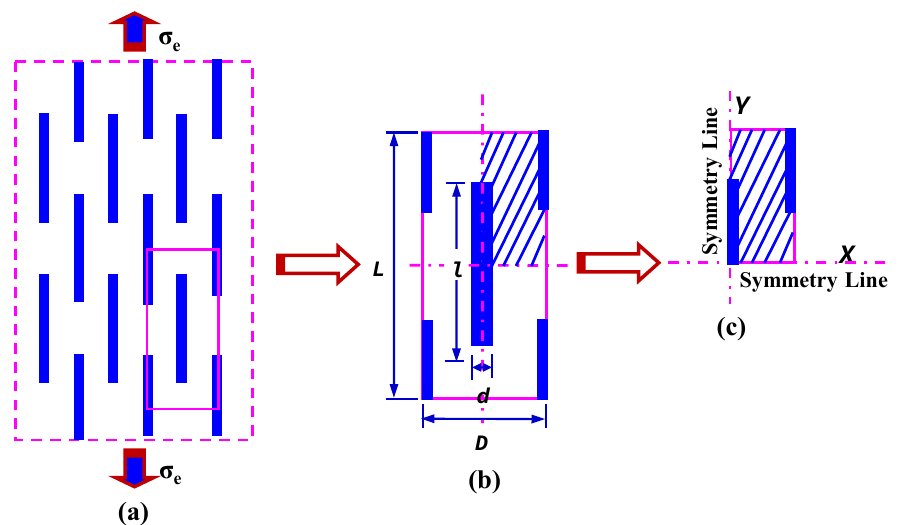
Figure 3. Representative volume element (RVE) of the stagger model used for the present computational scaling analysis. ( a ) Idealized identical staggering clay platelets; ( b ) a typical RVE; and ( c ) a quarter RVE for efficient simulation.